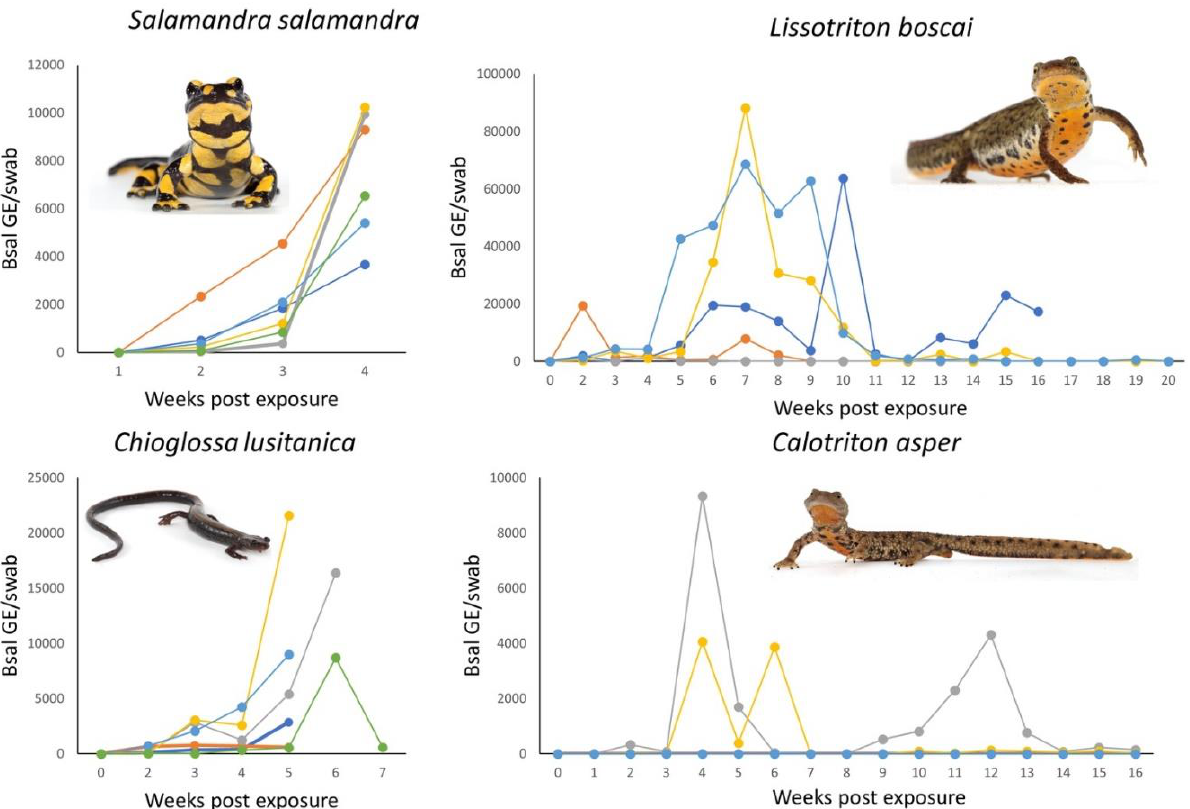
Figure 2. Overview of infection dynamics of Bsal after experimental exposure of salamanders to a single dose of 10 3 zoospores. Each line represents the infection dynamics of a single animal. All S. salamandra and C. lusitanica died, compared to one L. boscai and no C. asper . Infection loads are expressed as genomic equivalents (GE) of Bsal per swab per timepoint.